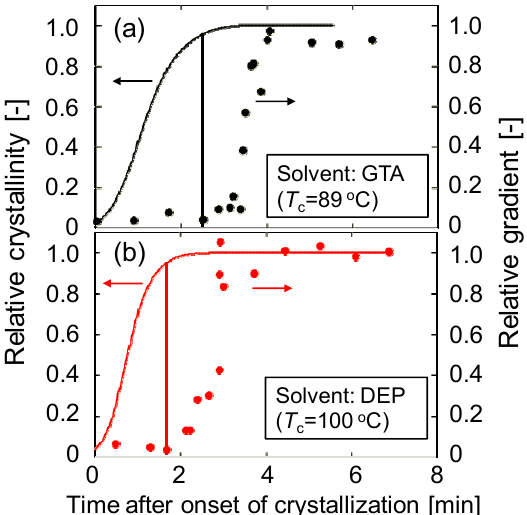
Figure 4. Comparison between relative gradient and relative crystallinity. ( a )